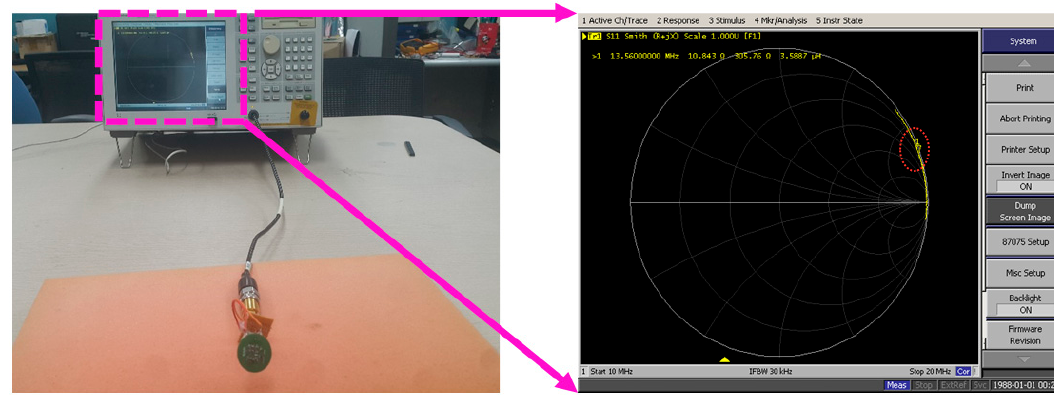
Figure 5. Inductance of the embedded coil in the smart skincare device tag.